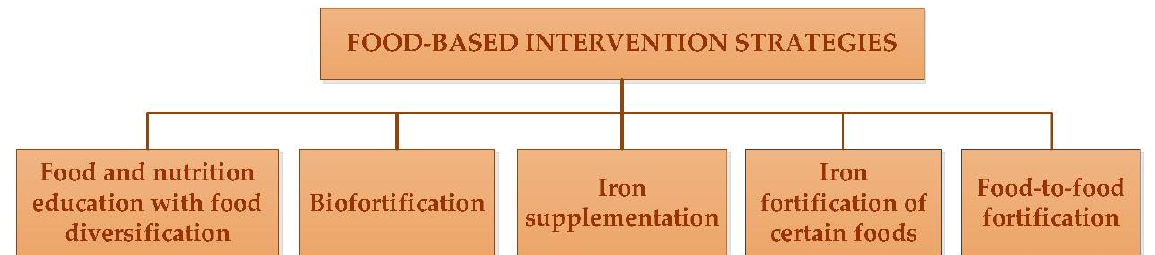
Figure 1. Prevention of iron deficiency: Intervention strategies.